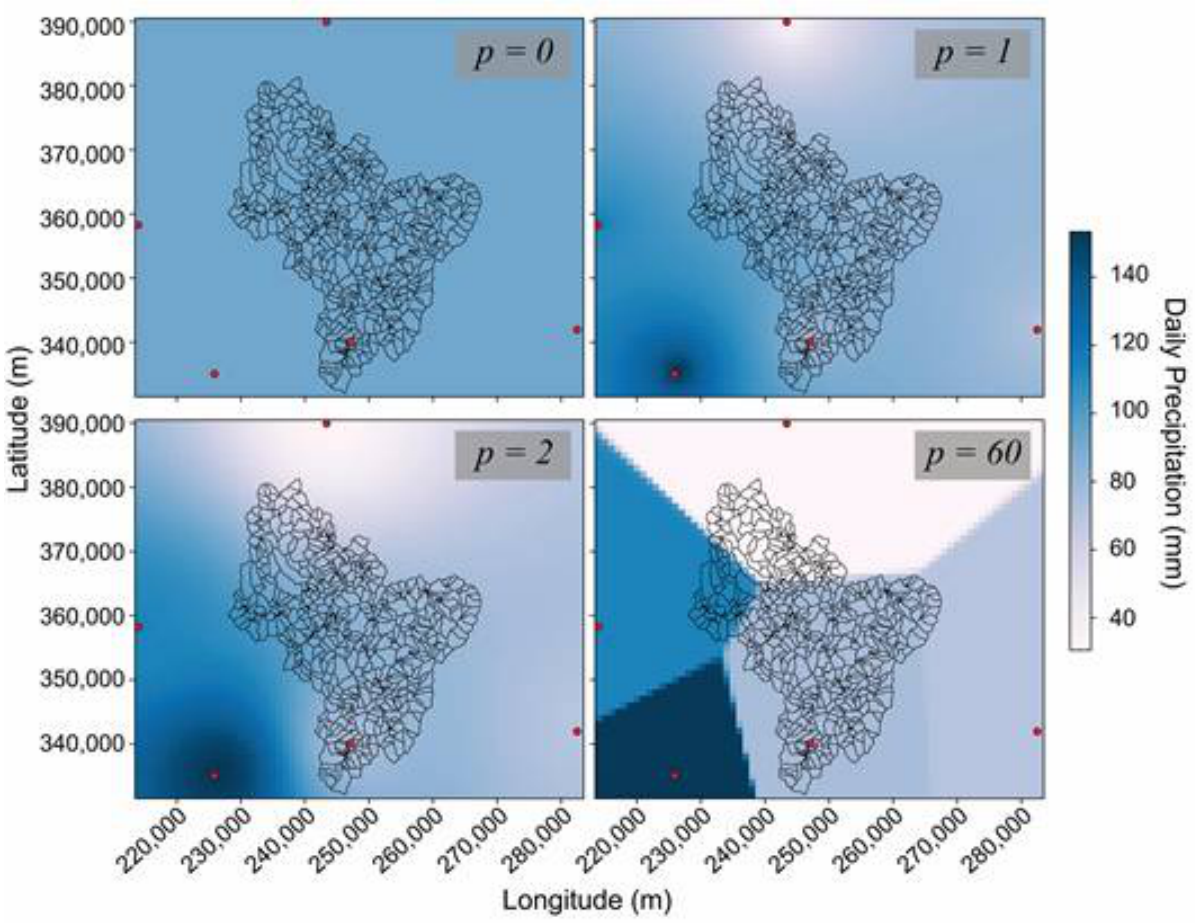
Figure 2. The visual comparison of IDW maps based on various powers ( (cid:1868) ) for the same event